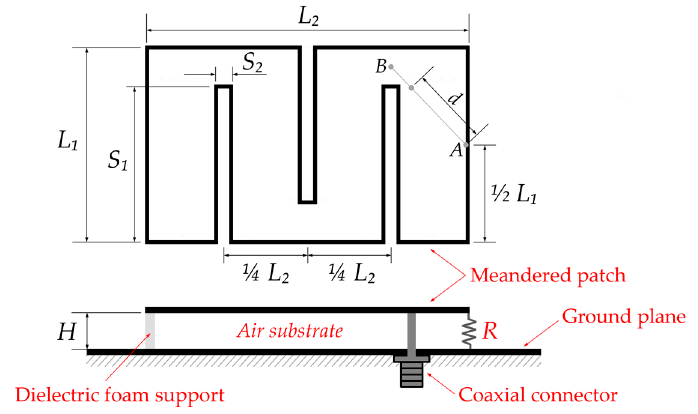
Figure 5. Schematic diagram of the meandered PIFA.